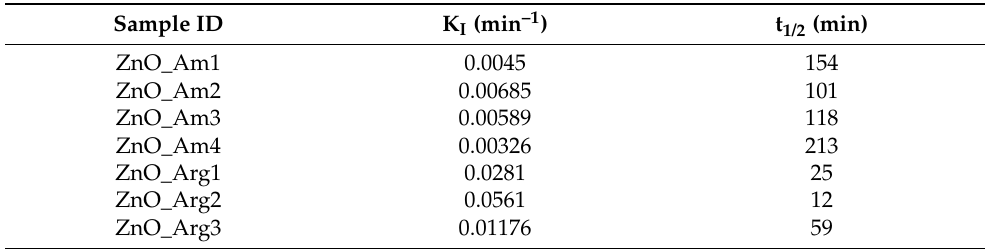
Table 3. Kinetic parameters for ZnO samples obtained under various conditions using the microwave-assisted method.